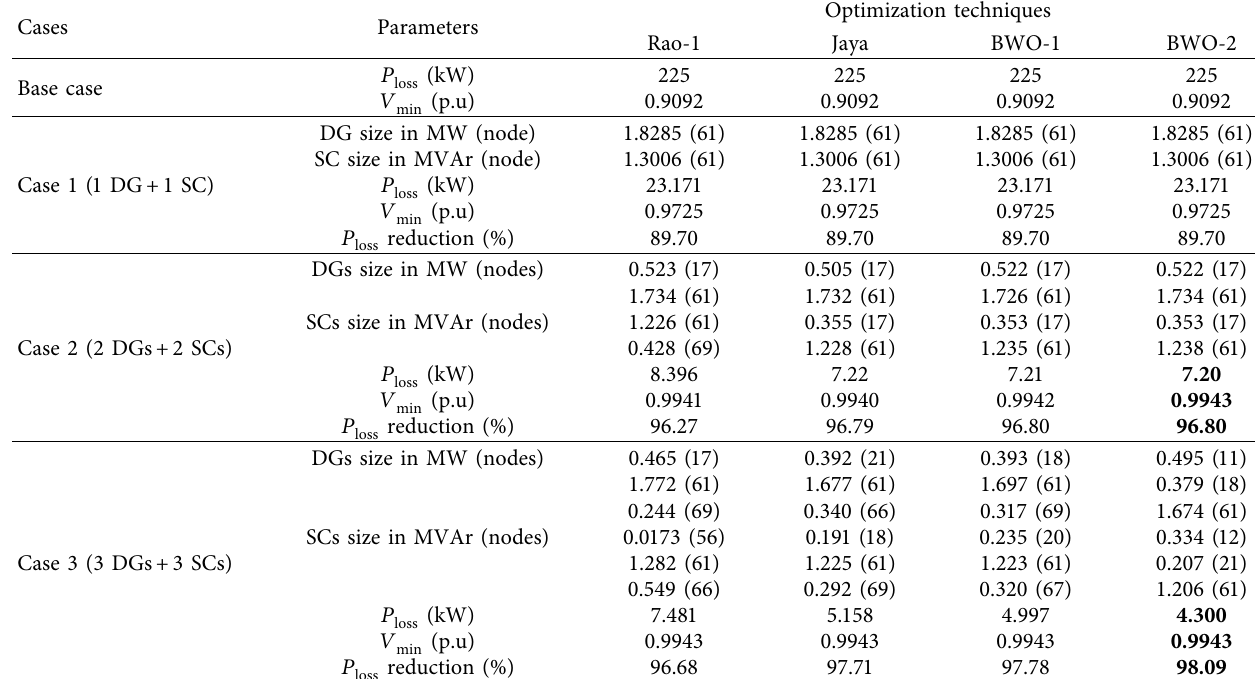
Table 8: Performance comparison of the Rao-1, Jaya, BWO-1, and BWO-2 for the 69-bus test